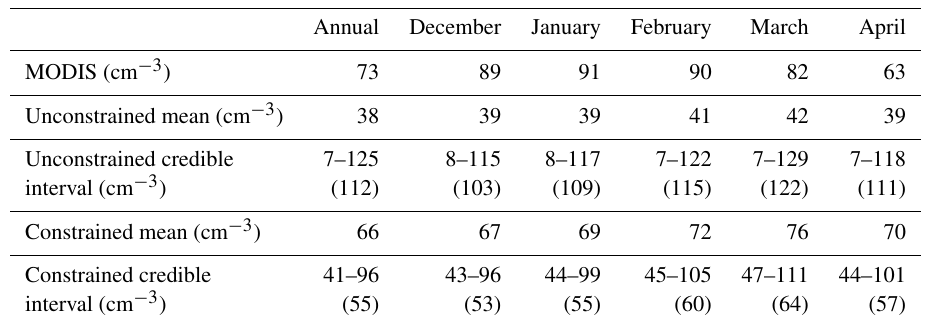
Figure 3. Marginal probability distributions for the 26 aerosol parameters after constraint using ACE-SPACE measurements. The density of parameter values in the unconstrained sample is shown as horizontal dashed lines (uniform sampling over the parameter space). Densities of constrained samples are shown in colour and are scaled so that the maximum densities in the constrained and unconstrained samples are aligned. The 25th, 50th, and 75th percentiles of each marginal distribution are shown in the central boxes. Parameter values on the x axes correspond to values used in the model (Yoshioka et al., 2019, Table S3). Table 1. Annual and monthly mean cloud drop number concentrations over the Southern Ocean (over the region between 50 and 60 ◦ S at around 1km altitude above sea level) in the original unconstrained sample and the sample of model variants constrained to ACE-SPACE campaign measurements. Mean values and 95% credible interval values are shown for each sample, with interquartile ranges in brackets. For comparison, we show cloud drop concentrations calculated from MODIS instrument data following Grosvenor et al. (2018) for the year 2008 (Supplement: Methods: